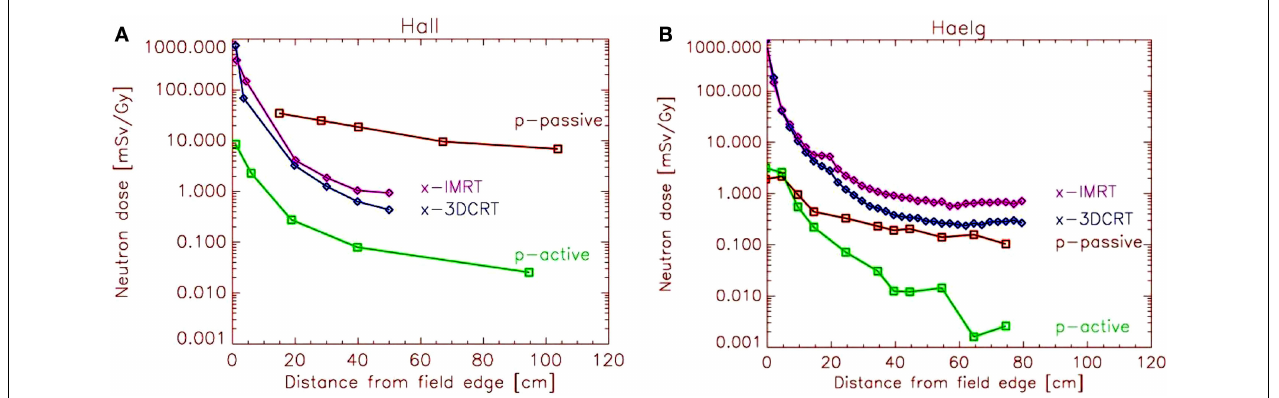
FIGURE 1 | (A) Eric Hall’s comparison (12) of neutron dose equivalent per treatment Gray as a function from the distance of the field edge. Measurements of several researchers were combined by scaling the neutron dose. (B) Comparison of neutron dose equivalent by Hälg et al. (13). The measurements were performed under the same conditions for each treatment